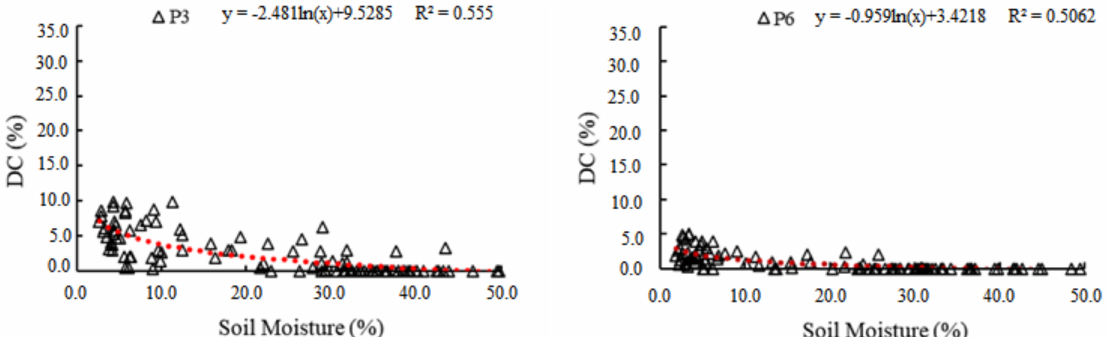
Figure 12. Soil moisture vs. Dc for the SCL cluster plots P3 and P6.